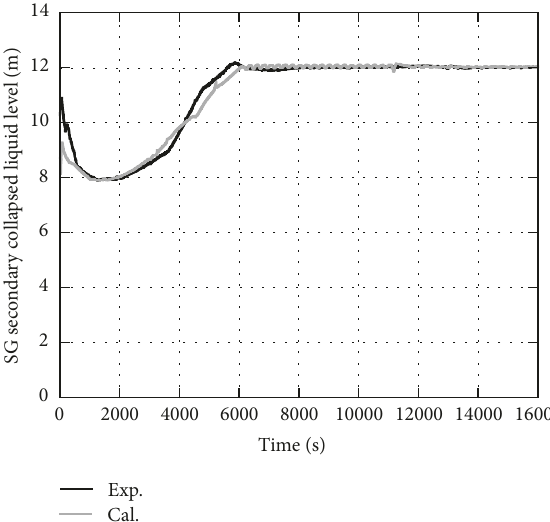
Figure 26: TR-LF-16testandRELAP5 results for SG secondary-side collapsed liquid level in loop A.